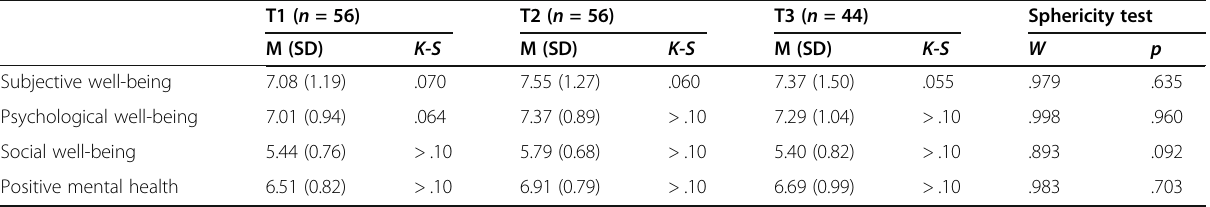
Table 2 Base line, post-test and 6-month measures: means, standard deviations, normalized test (Kolmogorov-Smirnov — K-S) and sphericity test (Mauchly ’ s W